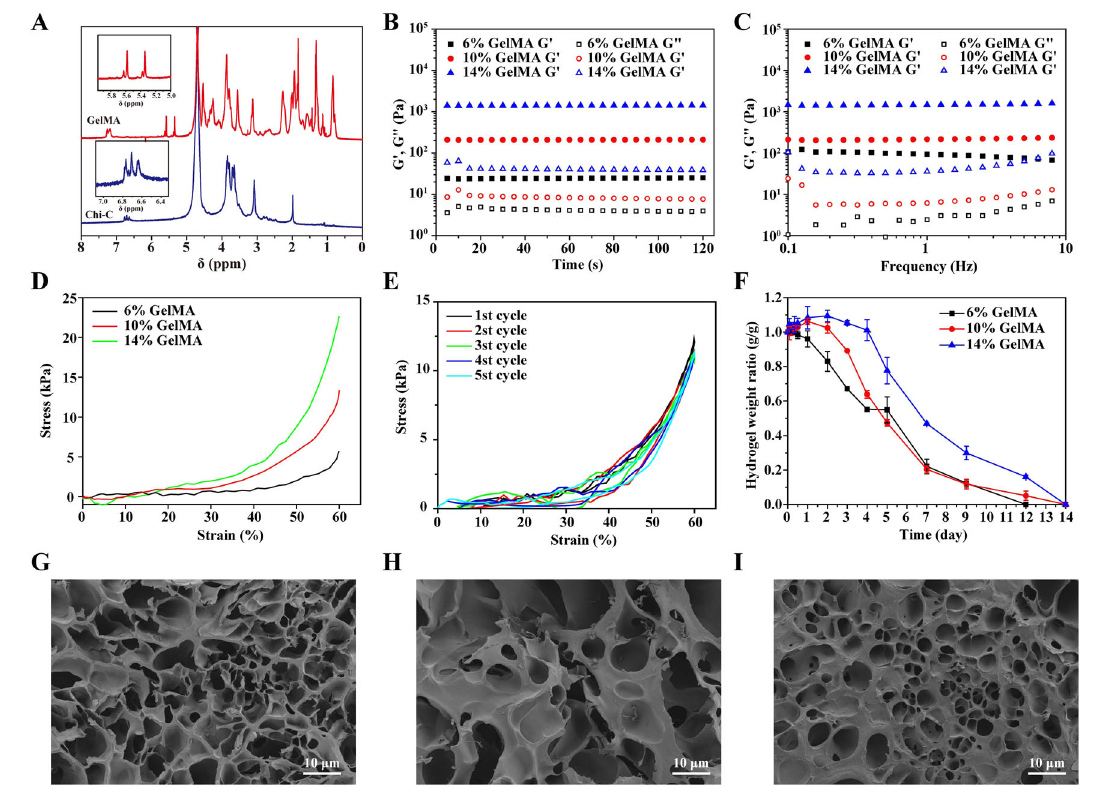
Fig. 1 Characterization of the hydrogel with different GelMA con- centration (6%, 10%, 14%). A 1 H NMR spectrum of GelMA and Chi- C. B Time sweep sequence and C frequency sweep sequence of hydrogel. D Static compression test of hydrogel. Cyclic compression